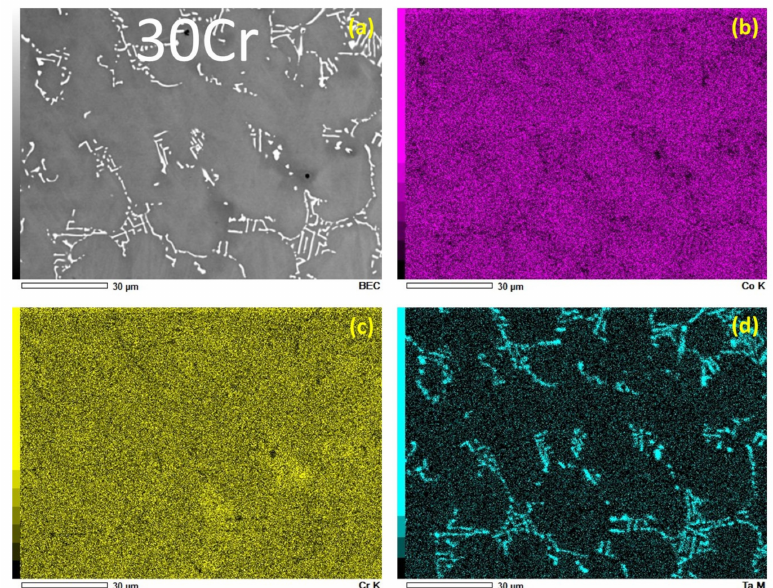
Figure 6. EDS X-cards (SEM/BSE: ( a ), Co: ( b ), Cr: ( c ), Ta: ( d )) illustrating the element repartitions in the microstructures of the two alloys with finely structured (matrix + TaC) eutectic compounds (here the 30Cr